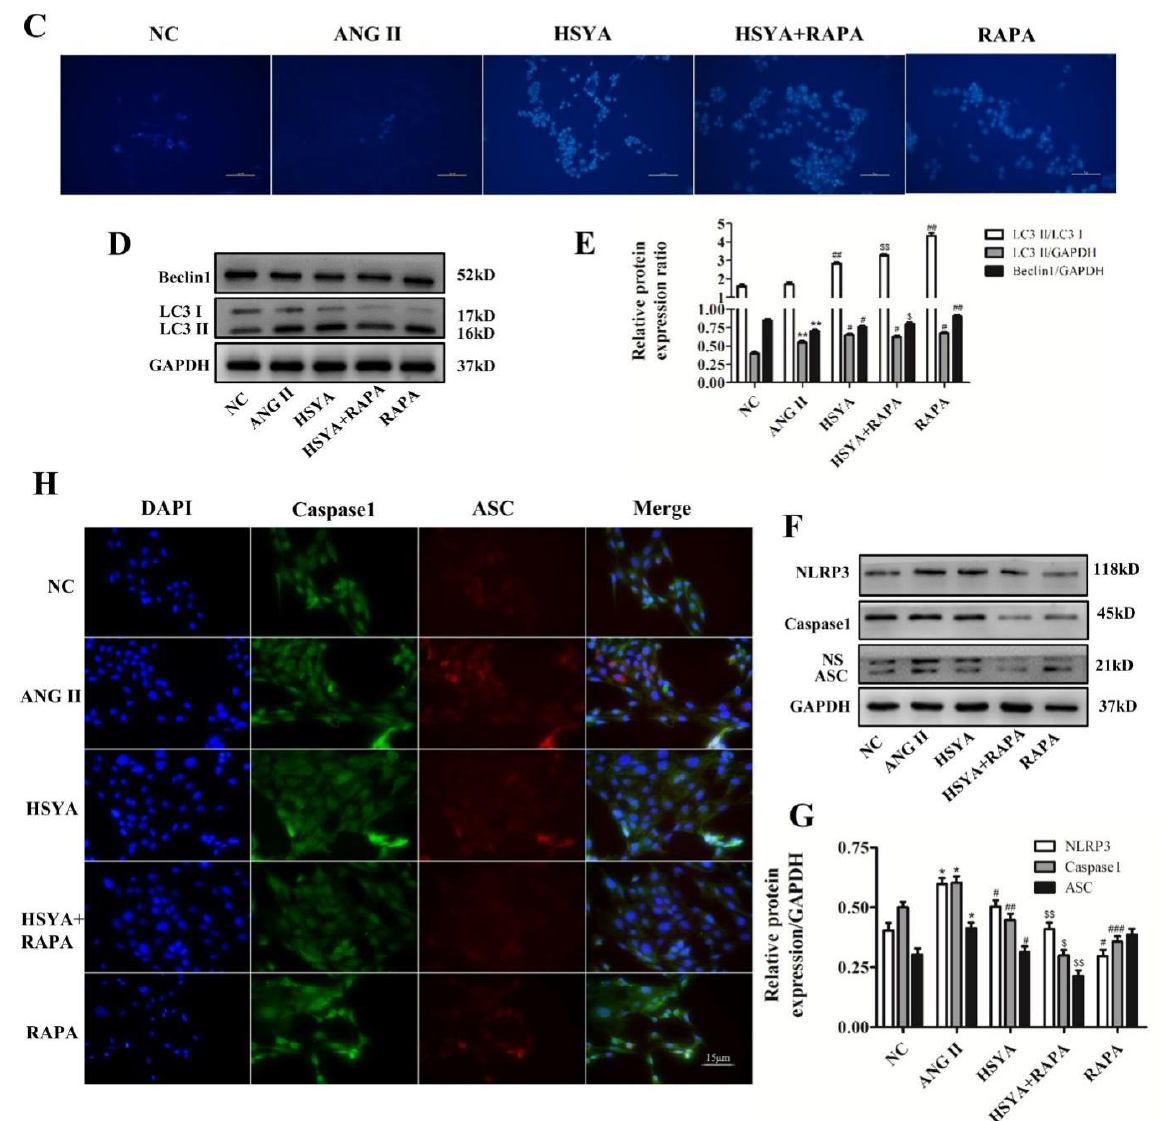
Figure 4. HSYA inhibits NLRP3 inflammasome activation via autophagy promotion. ( A ) Wound- healing assay of VAFs treated or untreated with ANG II, HSYA, and RAPA ( n = 3). Scale bar, 200 µ m. ( B ) The quantification of mobility of the VAFs in the five groups in ( A ). ( C ) The autophagosome (blue) was measured using MDC analysis ( n = 3). Scale bar, 100 µ m. ( D ) Western-blot analysis of Beclin1 and LC3 ( n = 4). ( E ) The quantification of the protein blots in ( D ). ( F ) Western-blot analysis of NLRP3-inflammasome-related proteins such as NLRP3, Caspase1, and ASC ( n = 4). ( G ) The quantification of the protein blots in ( F ). ( H ) Double immunofluorescence staining analysis of the coexpressed Caspase1 (green) and ASC (red) proteins in VAFs ( n = 4). Scale bar, 15 µ m. * Compared with the NC group, # compared with the ANG II group, $ compared with the LPS group, * /#/$ p < 0.05, ** / ##/$$ p < 0.01, *** / ### p < 0.001.